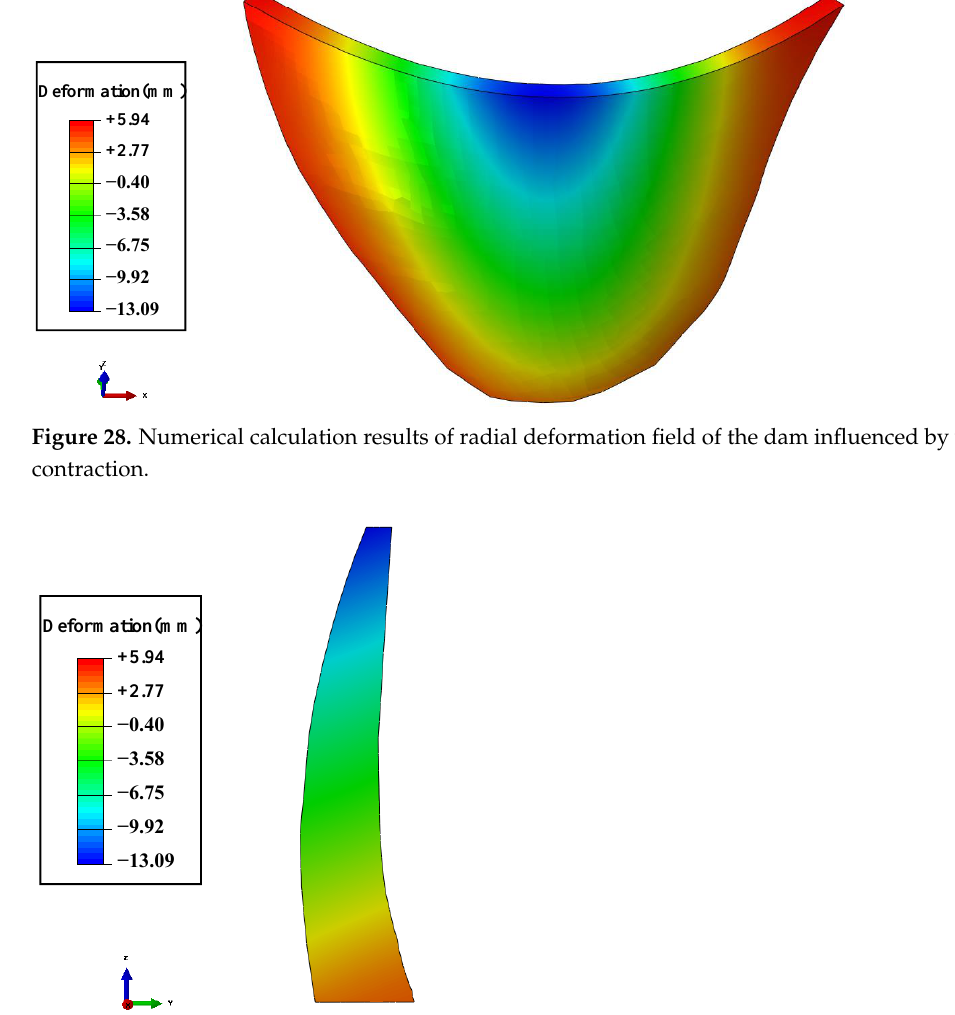
Figure 29. Numerical calculation results of arch crown beam radial deformation influenced by valley contraction.